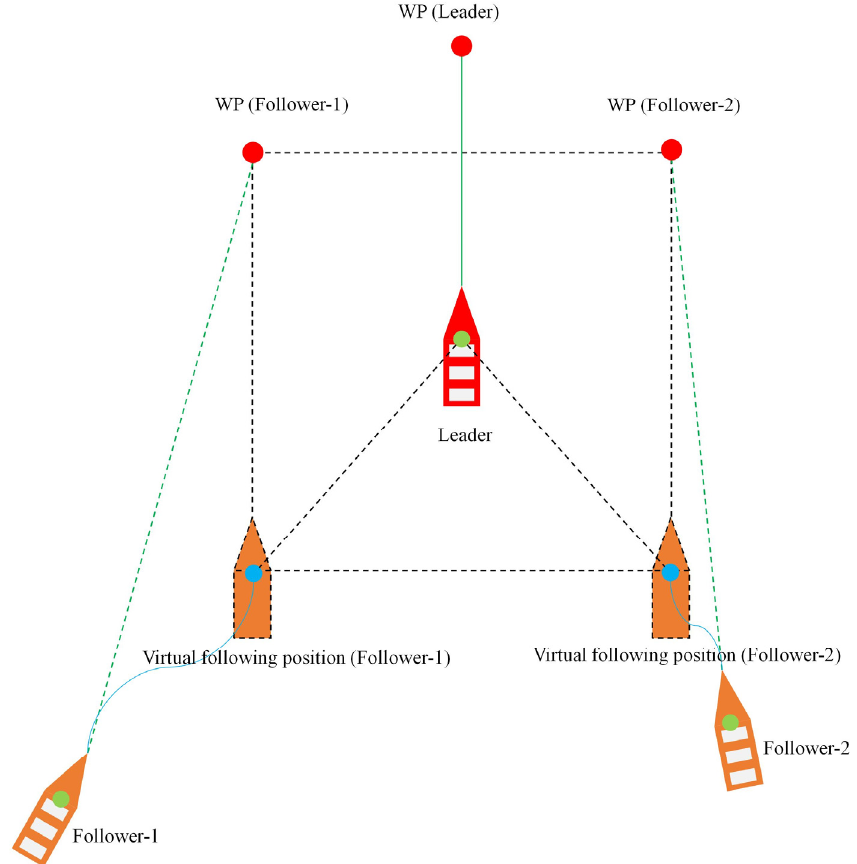
Figure 9. Follower and leader relationship in formation.